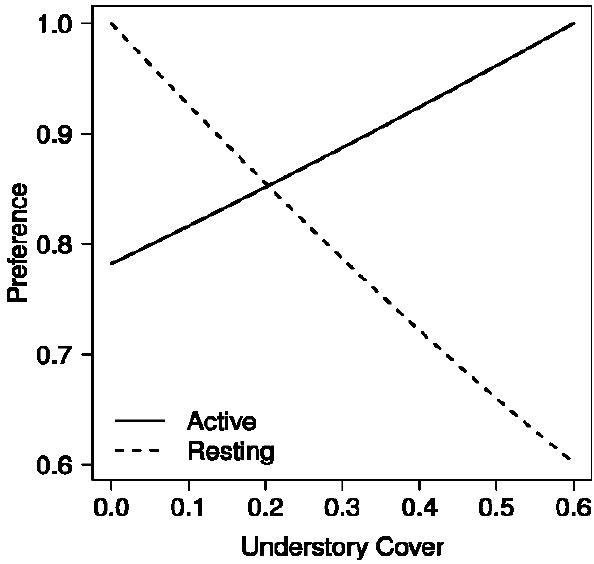
Figure 5. Predicted preference values for understory cover for active and resting roe deer; values represent expected values estimated by mixed conditional logistic regression; not-displayed variables were set to the corresponding data set